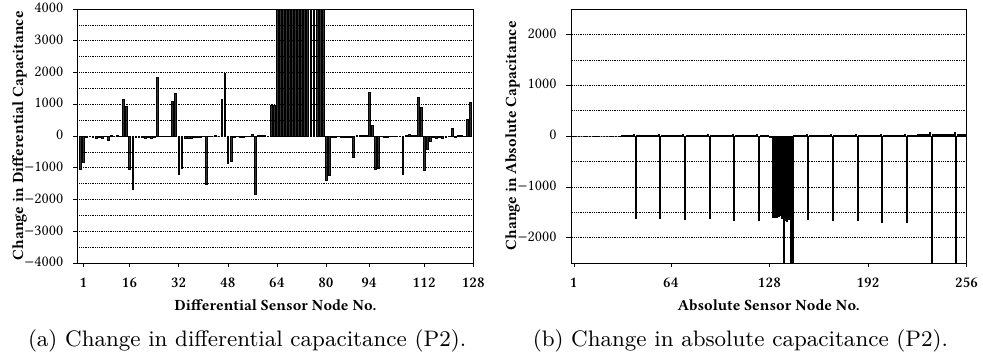
Figure 18: Attack Profile 2 (P2): result of a single hole of 0 . 3 mm in diameter, severing electrode Tx9 and Rx10. Clearly visible is the significant change in